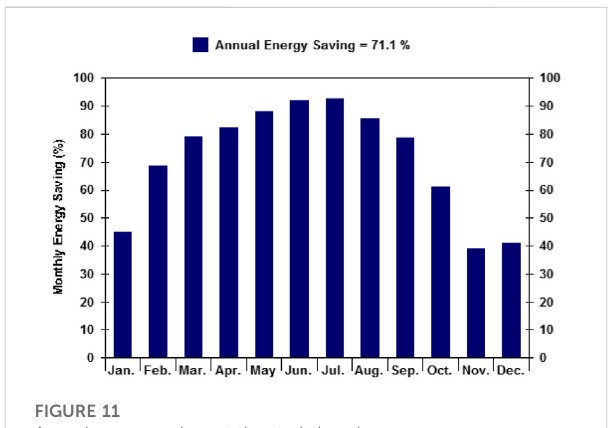
FIGURE 11 Annual energy savings at the study